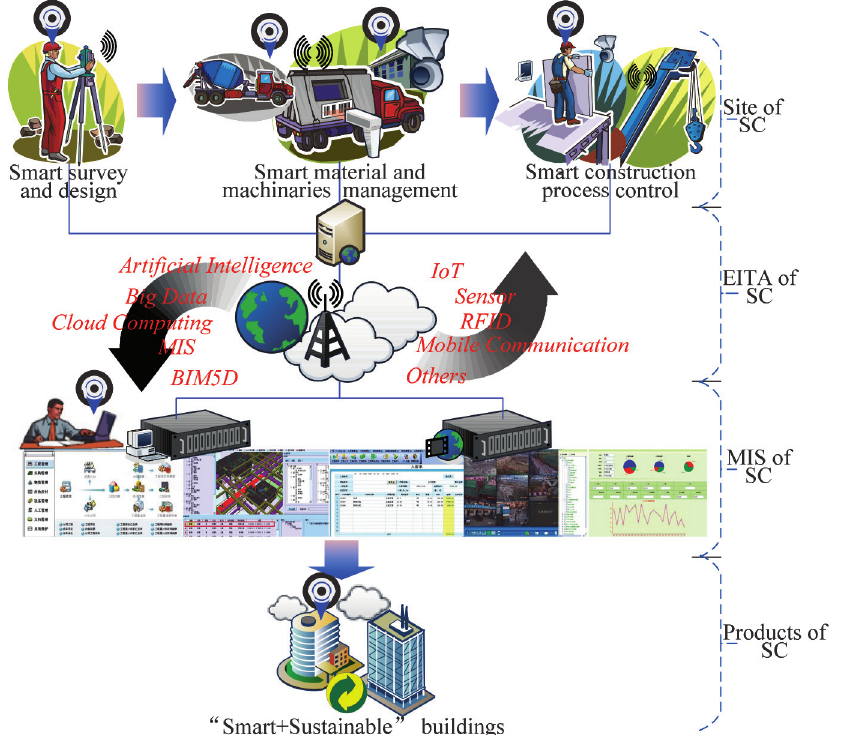
Figure 1. Basic structure of emerging information technology applied to the development of smart construction (abbreviated as SC)